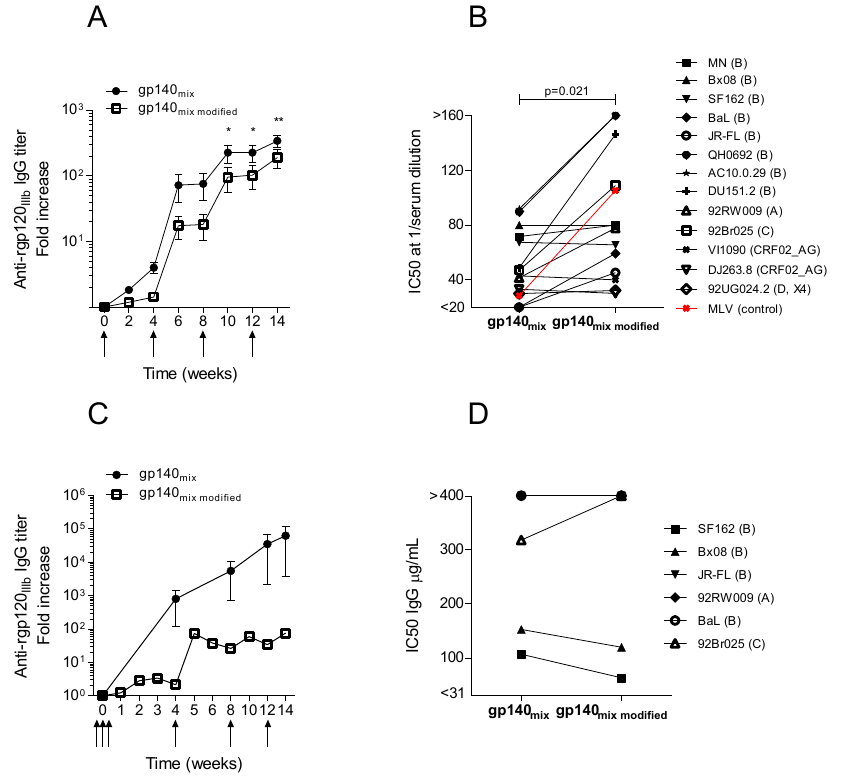
Figure 4. Comparison of the immune response in vaccinated guinea pigs ( A , B ) and rabbits ( C , D ) with plasmid DNA encoding syn.gp140 or syn.gp140 Average IgG mix mix modified. response against recombinant gp120 (rgp120 ) in immunized ( A ) guinea pigs (n = 4) and IIIb IIIb ( C ) rabbits (n = 4). Immunization time points are indicated with arrows. Asterisk indicates significant difference between the two immunization groups (* p < 0.05, ** p < 0.01, two-way ANOVA). Average neutralizing activity, expressed as IC50, of ( B ) diluted guinea pig serum or ( D ) purified rabbit IgG from week 14 animal sera against pseudotype virus strains of clade A–D and CRF02_AG. Amphotropic murine leukemia virus (MLV) pseudotype virus was included as control for the non-specific activity in experiments with guinea pig serum (red). Results from syn.gp140 immunizations were derived from Figure mix